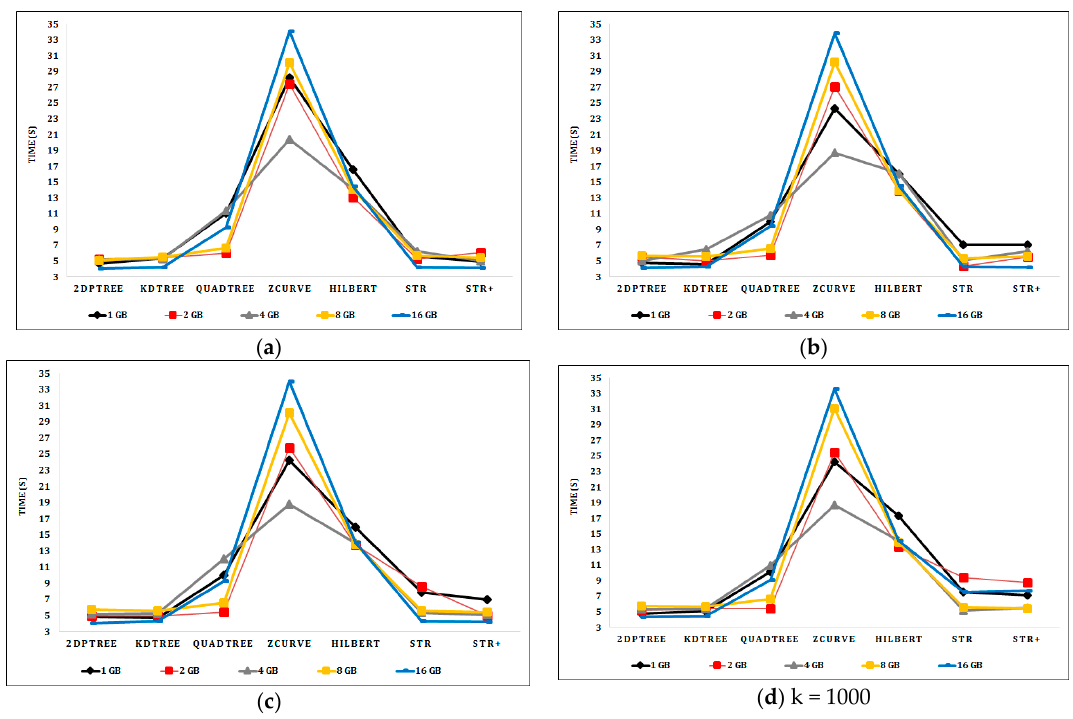
Figure 9. kNN query execution time for indexed synthetic datasets: ( a ) With k = 1; ( b ) with k = 10; ( c ) with k = 100; ( d ) with k = 1000.